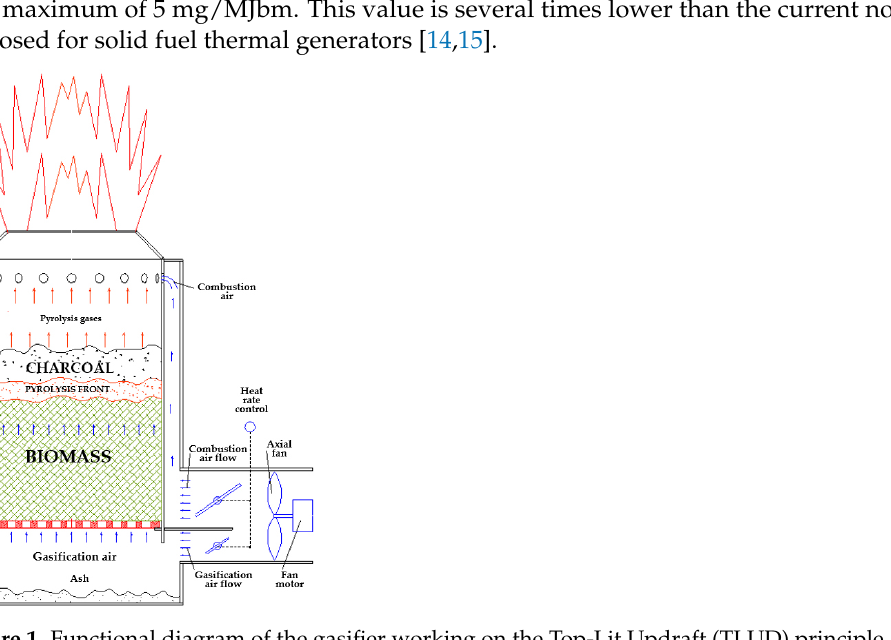
Figure 1. Functional diagram of the gasifier working on the Top-Lit Updraft (TLUD) principle [13].